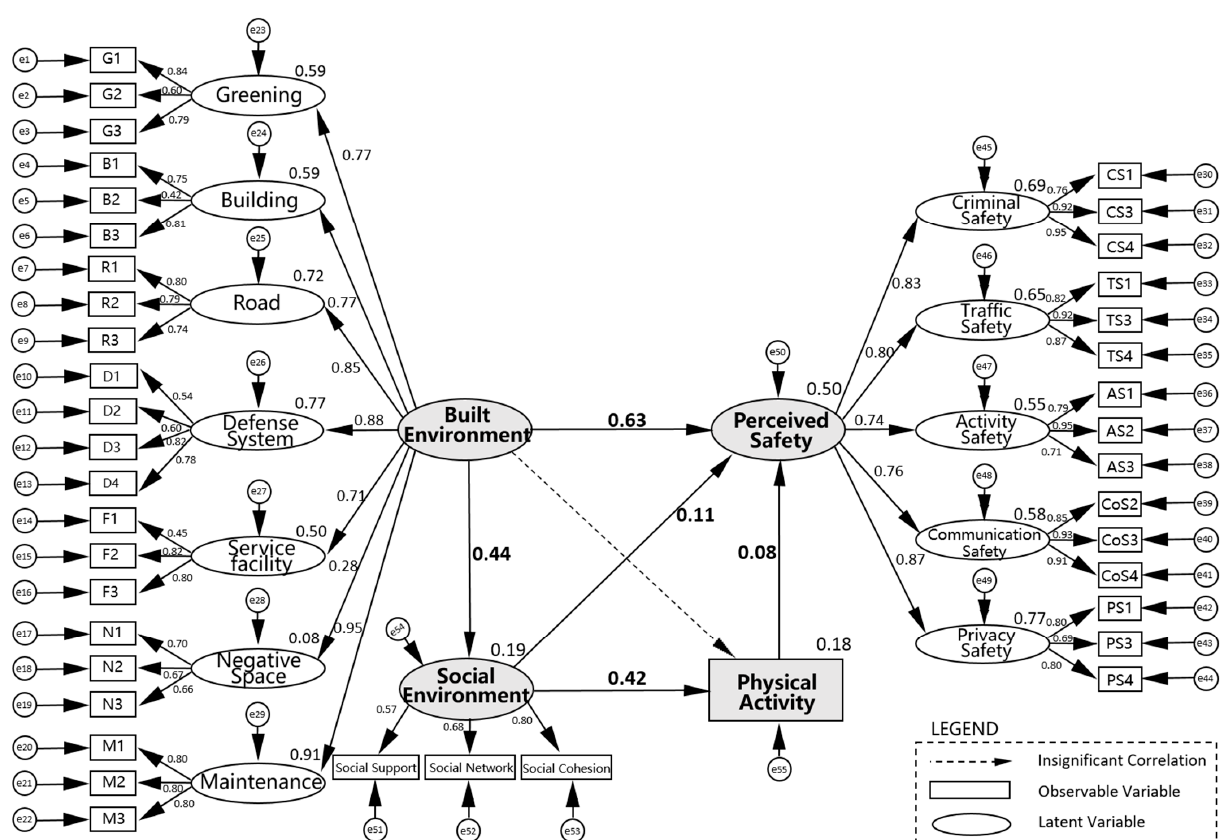
Figure 4. Structural equation model of built environment, social environment, physical activity and perceived safety (N = 535). Note: Full line paths show the statistically significant associations between factors at 95% significant level and the standardized coefficients. Table 1 shows the full names of variables.